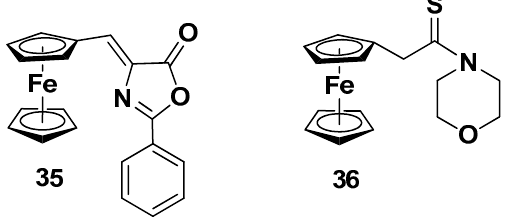
Figure 17. Structures of ferrocene azalactone ( 35 ) and thiomorpholide amido methyl ferrocene ( 36 ).